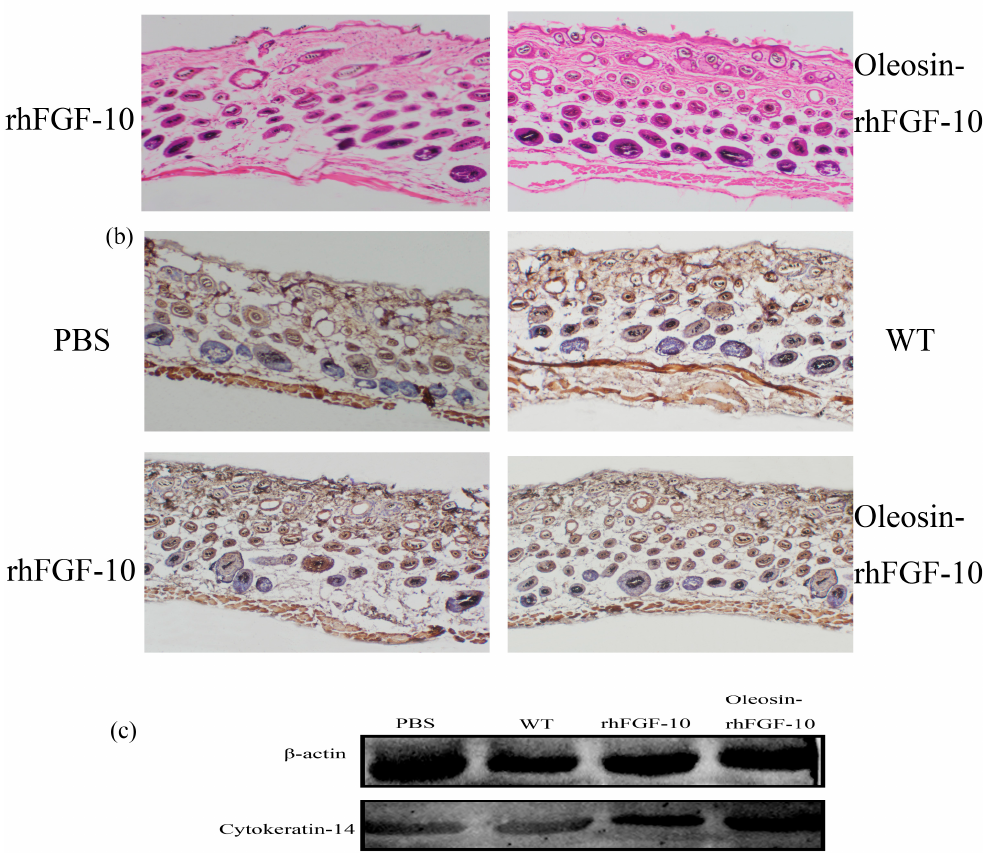
Figure 9. The effect of oleosin-rhFGF-10 on hair-follicle regeneration. ( a ) Images of hematoxylin- and eosin-stained skin sections following four treatments, showing hair regeneration on day 10. Images are shown at 100 × magnification; ( b ) immunohistochemistry of the expression ofcytokeratin-14; ( c ) western blot quantification method for objective evaluation for expressing cytokeratin-14 in skin.